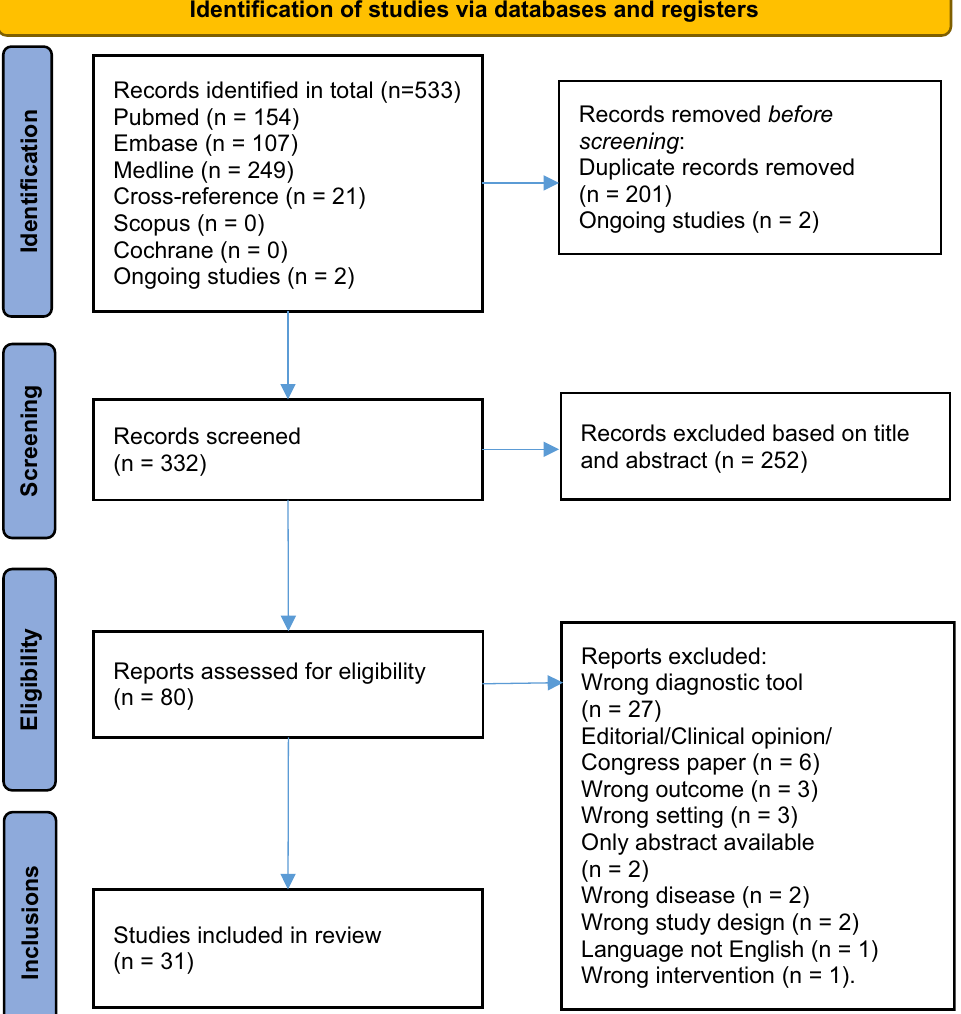
Fig. 1 PRISMA flowchart